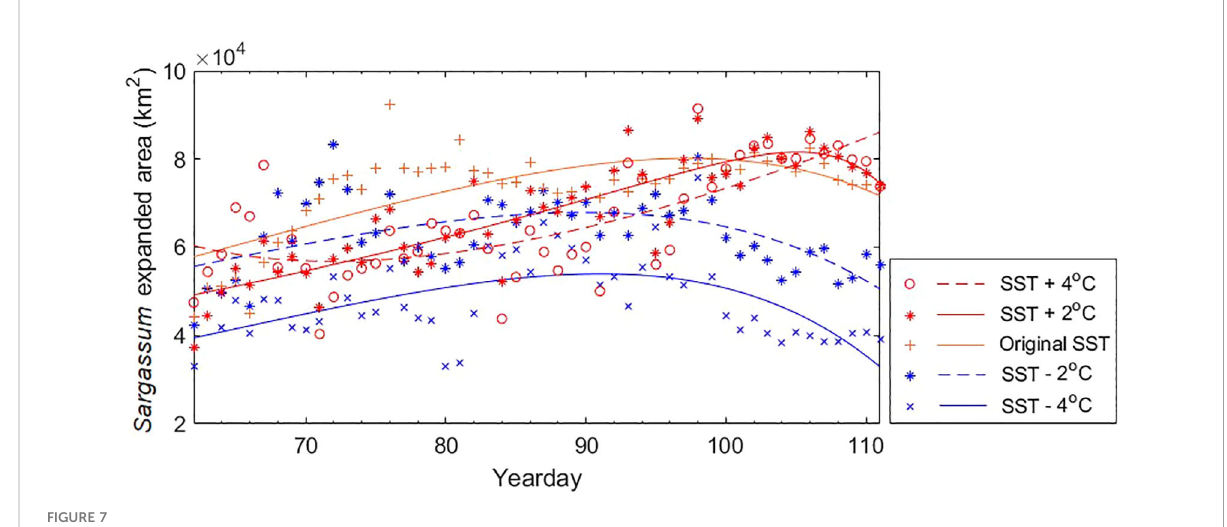
FIGURE 7 Sargassum expanded areas and fi tted curves according to yearday for fi ve cases in 2016 corresponding to Figure 7. Five cases include (1) SST + 4 °C, (2) SST + 2 °C, (3) original SST, (3) SST − 2 °C, and (4) SST − 4 °C. Sargassum or non- Sargassum pixels were estimated using the BT-3 model.